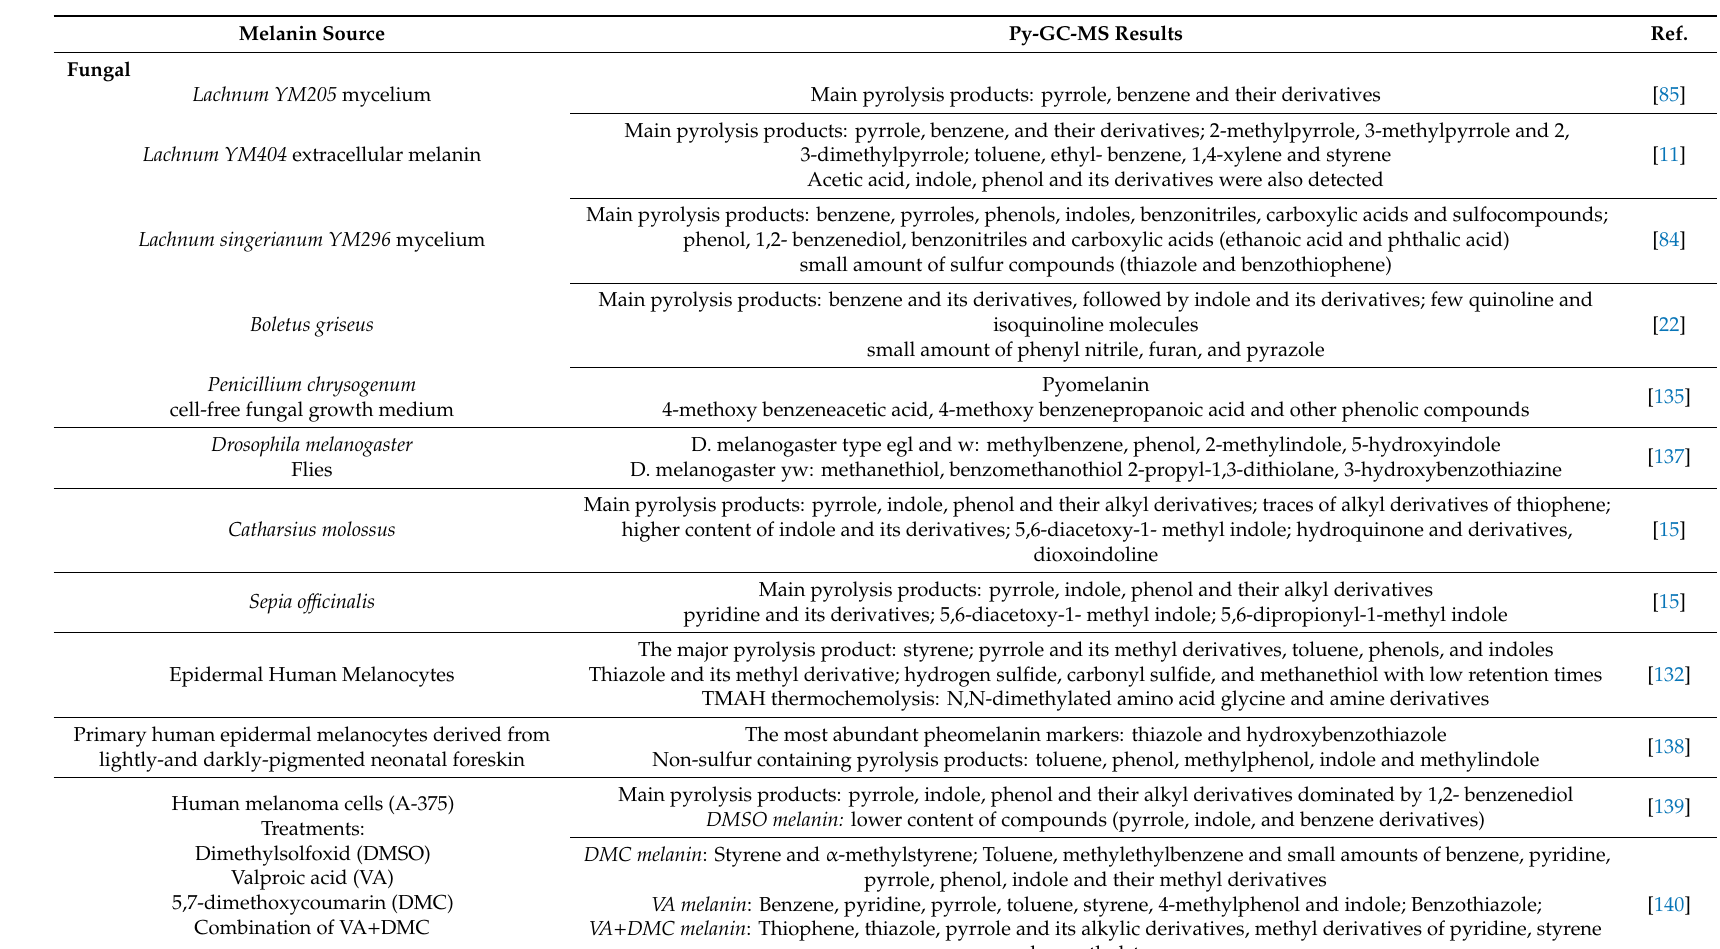
Table 11. py-GC-MS analysis of natural